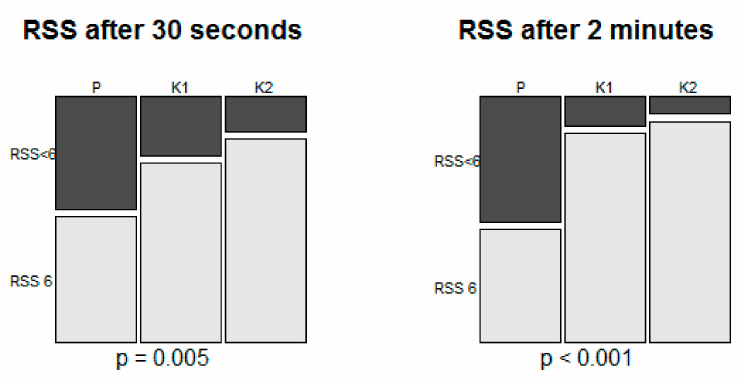
Figure 2. The proportions of the patients who reached six on the RSS at 30 s and 2 min after induction. RSS, Ramsay sedation